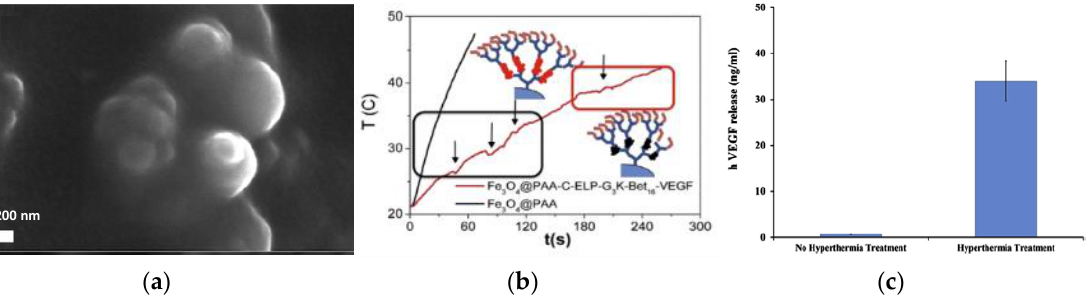
Figure 14. ( a ) SEM micrograph of Fe3O4@PAA-C-ELP-G3K-Bet16-VEGF, ( b ) hyperthermia Treatment of Fe 3 O 4 @PAA and Fe 3 O 4 @PAA-C-ELP-G3K-Bet16 samples immersed in phosphate buffered saline, pH 7.4, with a volume of 240 µL and a magnetite concentration of 40 µg/µL, and ( c ) release of hVEGF from Fe 3 O 4 @PAA-C-ELP-G3K-Bet16-VEGF after hyperthermia treatment. Negative control shows no